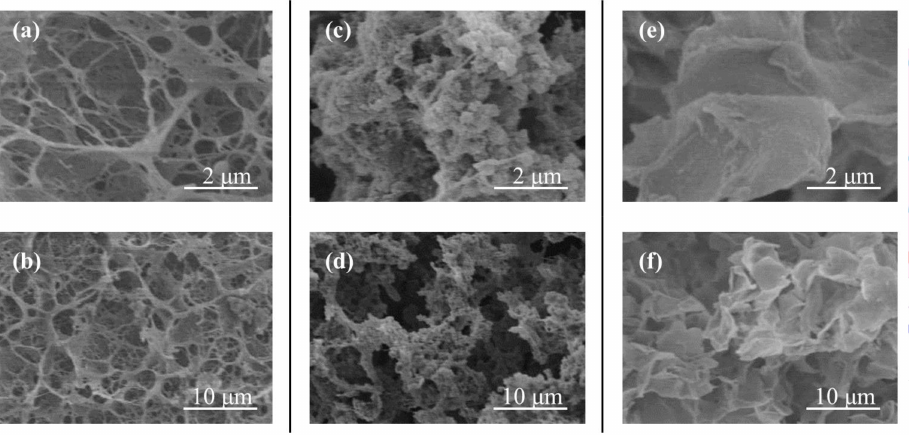
Figure 3. Scanning electron microscopic (SEM) images of lyophilized samples from PTHF ( a , b ), PCL ( c , d ), and PLLA ( e , f